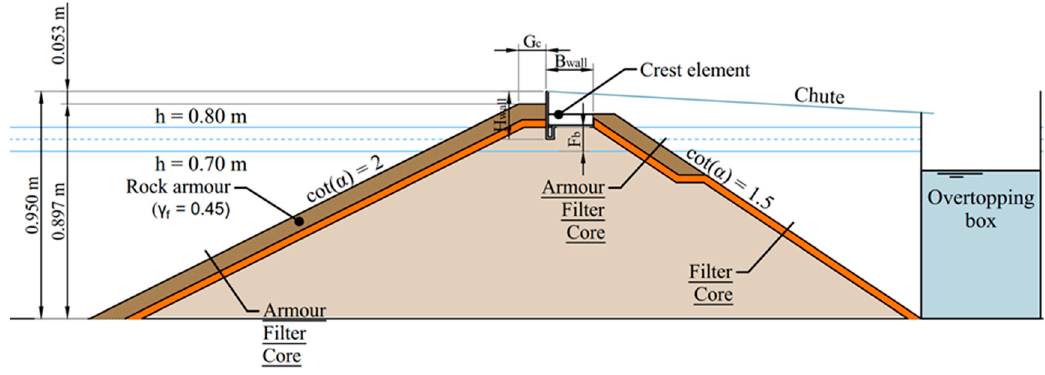
Figure 2. Tested cross-section [5].